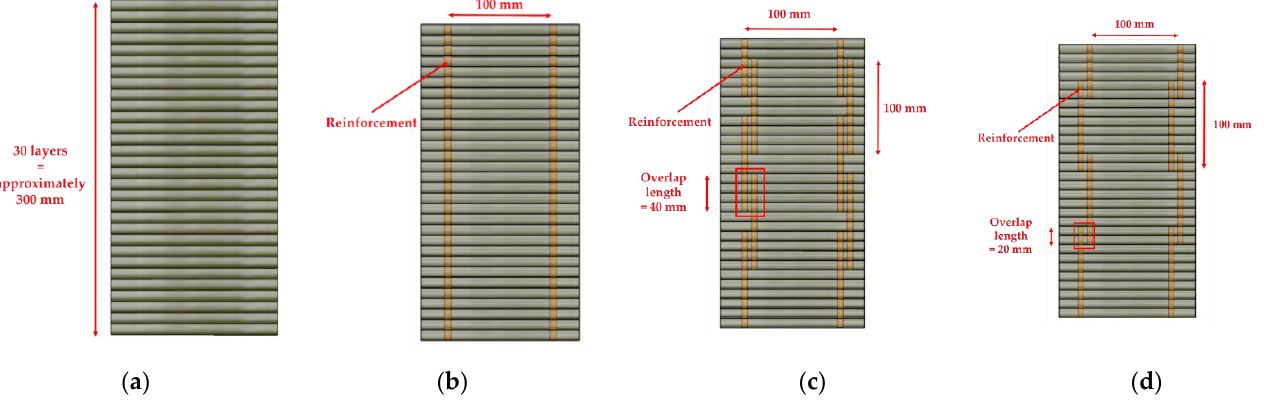
Figure 4. Schematics of interlayer reinforcements. ( a ) S1; ( b ) S2–300; ( c ) S3–40; ( d ) S4–20. Structure S2–300 was printed with the same rectangular shape as structure S1, but the two long walls of structure S2–300 were reinforced by interlayer reinforcements with a spacing of 100 mm in the printing direction.